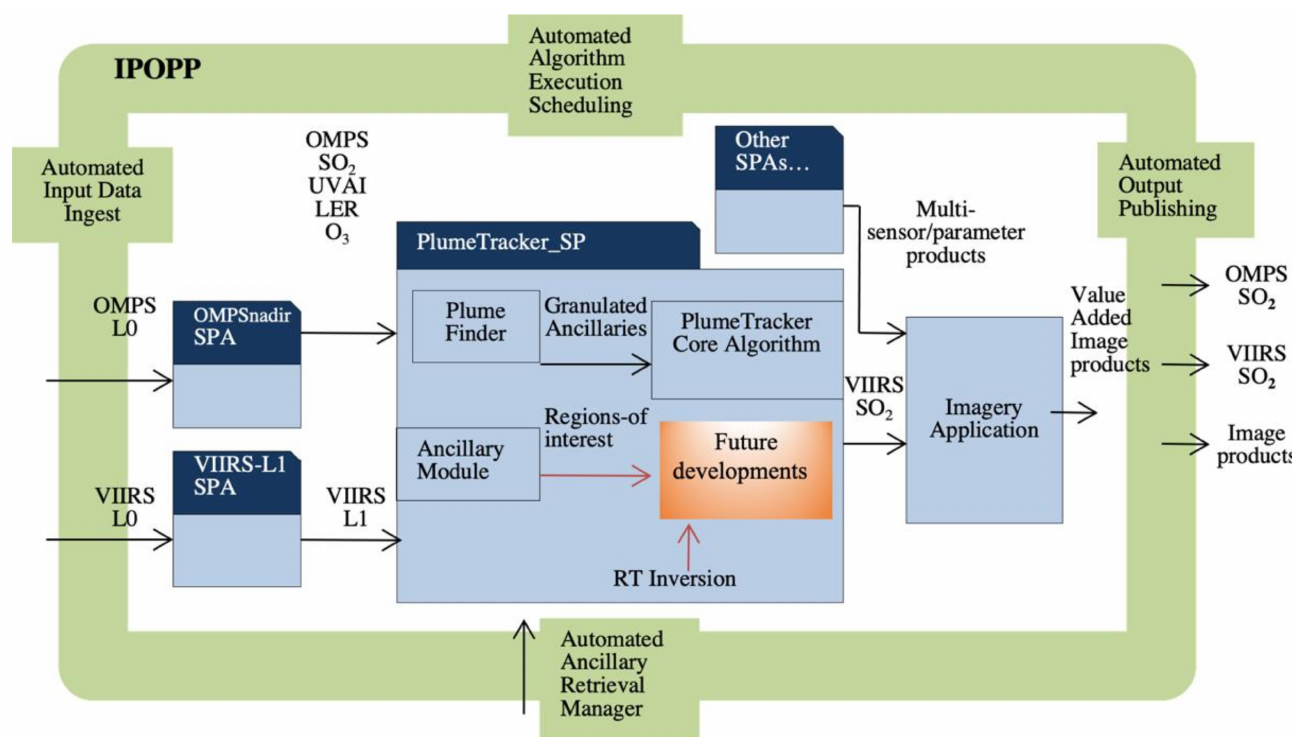
Figure 6. The VIIRS-SO 2 and OMPSnadir science processing algorithms’ (SPAs) architecture within the DRL’s IPOPP